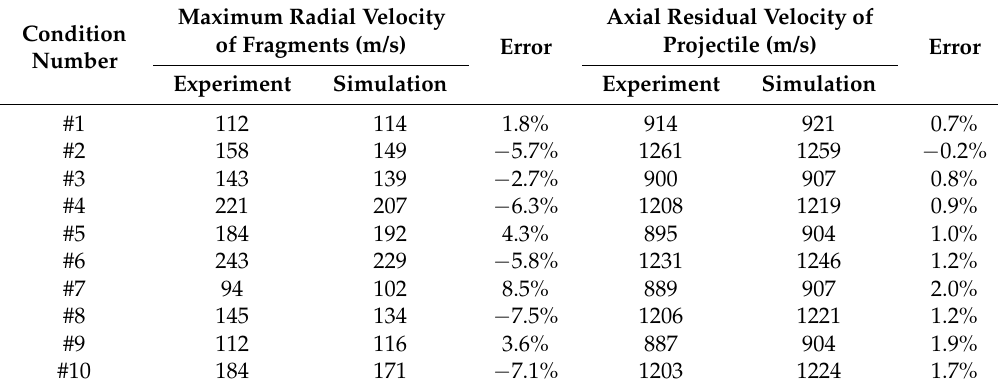
Table 3. Comparison of the maximum radial velocity of fragments and the axial residual velocity of the projectile between the simulation results and experimental